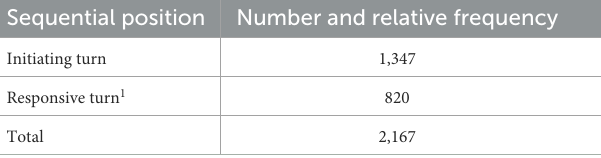
TABLE 2 The relative frequency in different sequential positions. Sequential